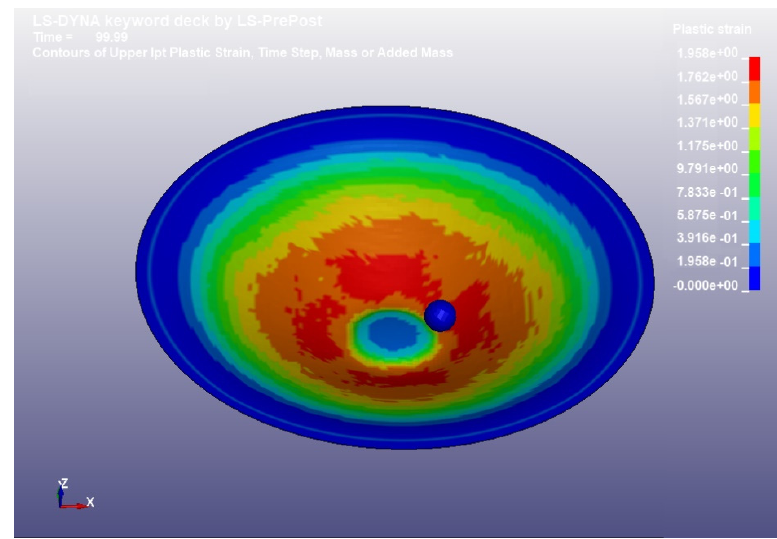
Figure 13. A contact area between tool and sheet for different tool diameters.